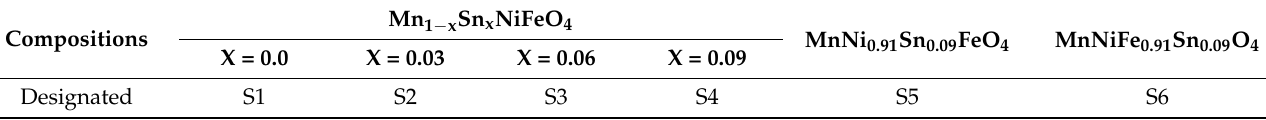
Figure 1. Illustration of the experimental process of the ceramic specimen. Table 1. The composition of Sn-doped MnNiFeO 4